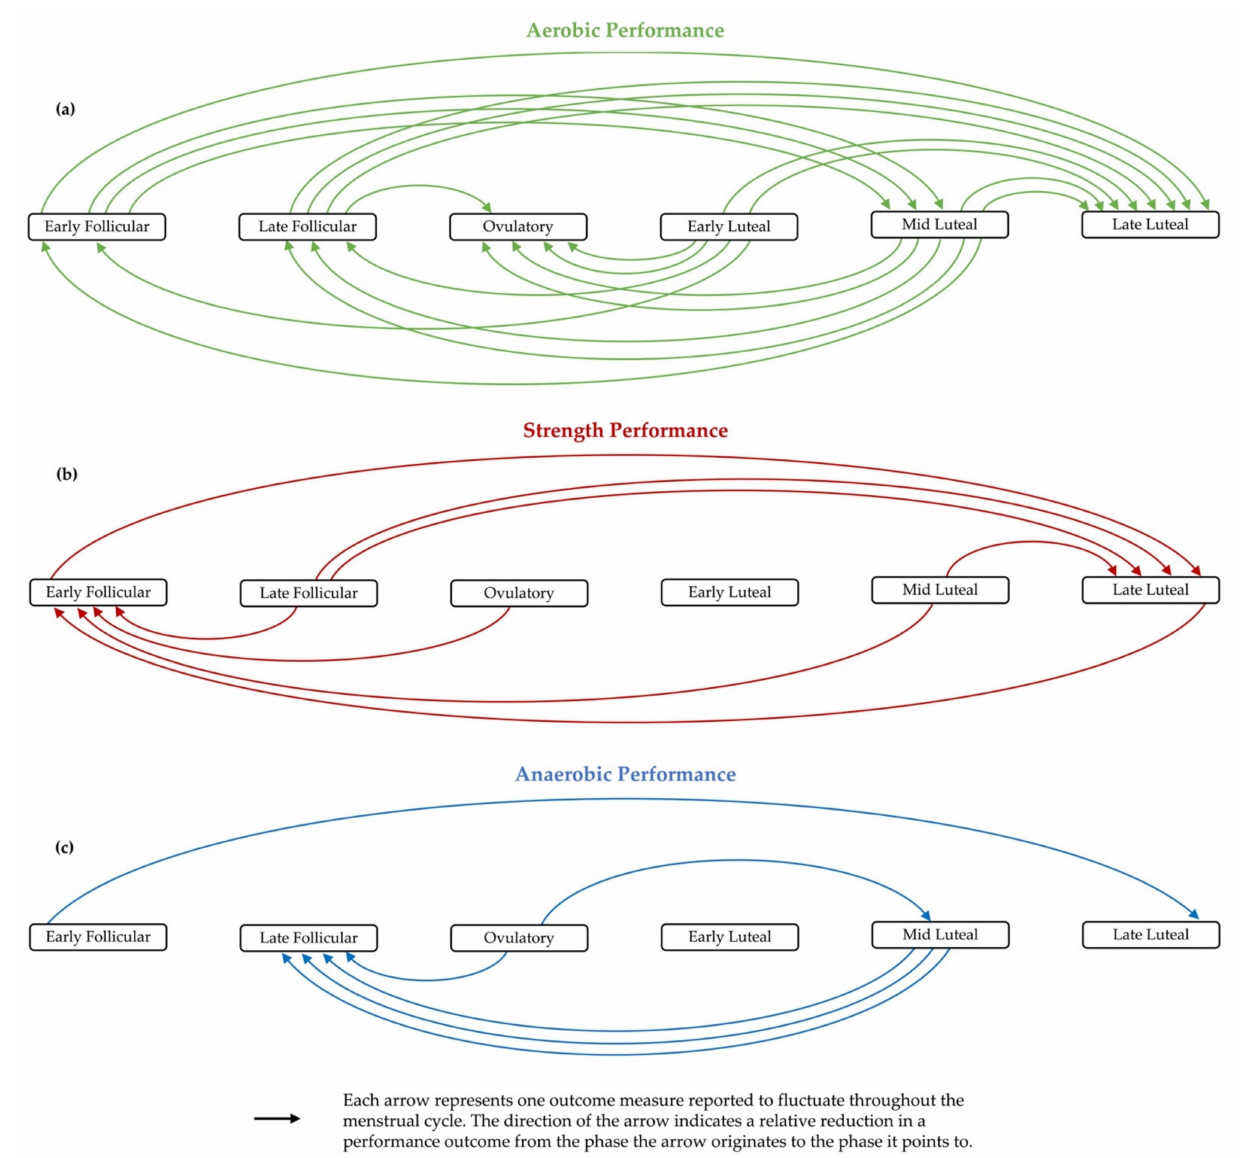
Figure 2. Summary of the changes in physical performance outcomes throughout the menstrual cycle observed in the included studies that reported that physical performance fluctuated across the menstrual cycle; ( a ) changes in aerobic performance outcomes; ( b ) changes in strength performance outcomes; ( c ) changes in anaerobic performance